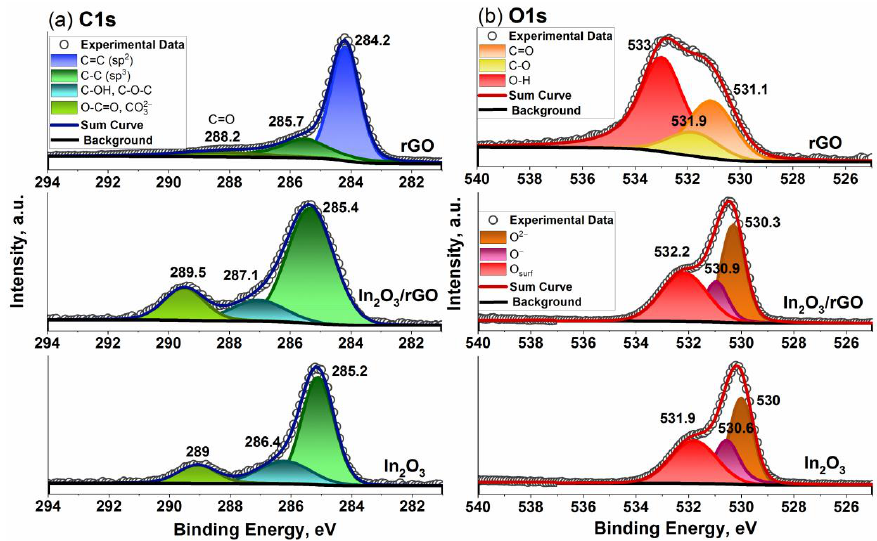
Figure 4. C 1s ( a ) and O 1s ( b ) X-ray photoelectron spectra of the In 2 O 3 and In 2 O 3 /rGO (1%) com- posite.